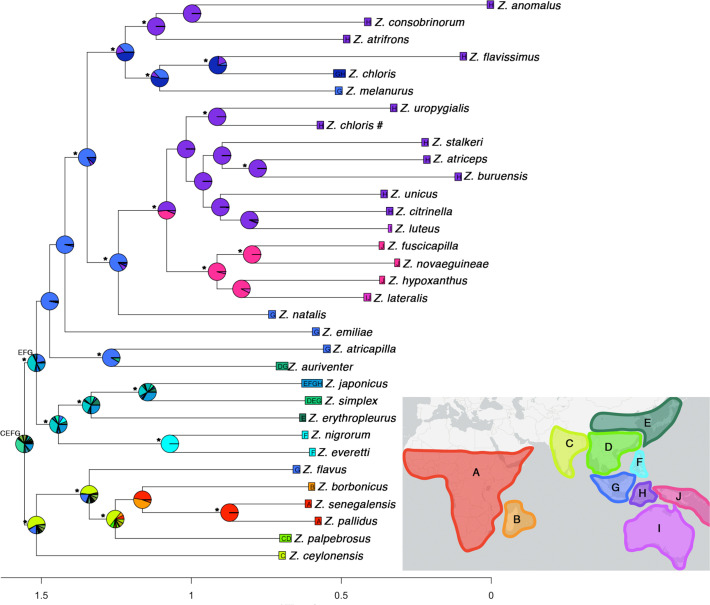
Ancestral range estimation of the genus Zosterops using the DEC+j model in BioGeoBEARS on a concatenated maximum likelihood tree.The results of BioGeoBEARS are shown as pie charts colored in relative proportions of the most likely ancestral range. Nodes with 100% bootstrap support are indicated with * at the side. Scale at the bottom indicates rate of molecular changes rather than divergence time. Geographical areas defined for ancestral range estimation: (A) Afrotropical region, (B) West Indian Ocean islands, (C) South Asia, (D) mainland Southeast Asia, (E) East Asia, (F) Philippines, (G) Sundaic region, (H) Wallacea, (I) Australia, and (J) Melanesia.